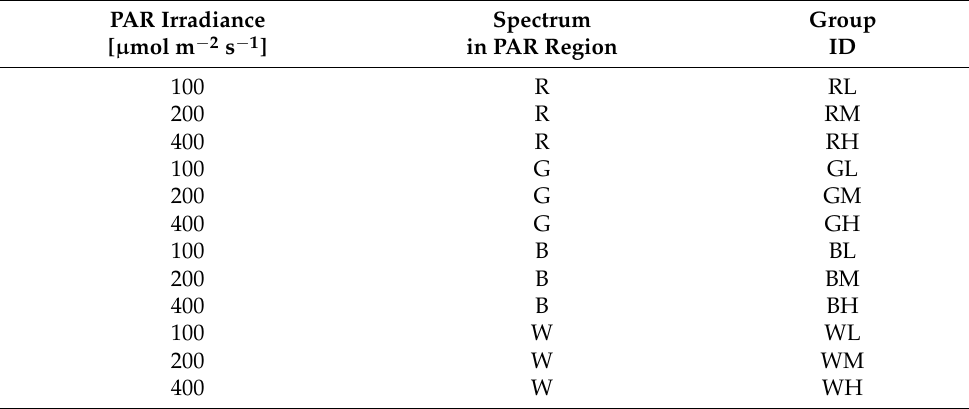
Table 2. Specification of light treatments (i.e., irradiance and spectral quality) used during the 7-day acclimation period of spring barley plants ( Hordeum vulgare L. cv Bojos). W (white light), B (blue light), R (red light), G (green light), L (low irradiance, 100 µ mol m − 2 s − 1 ), M (medium